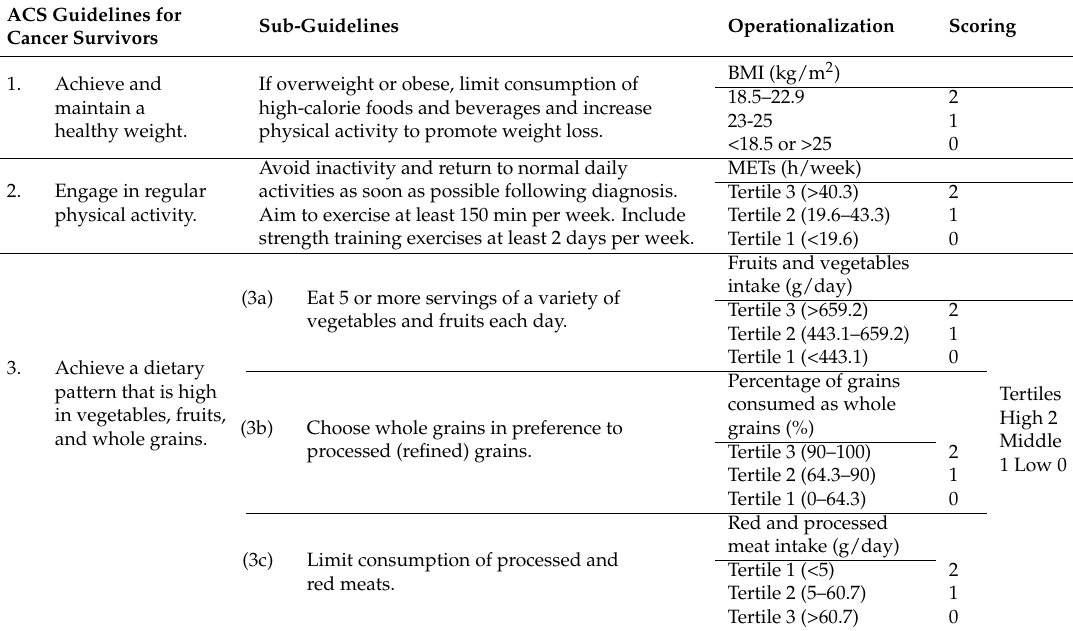
Table 1. Operationalization of adherence to ACS